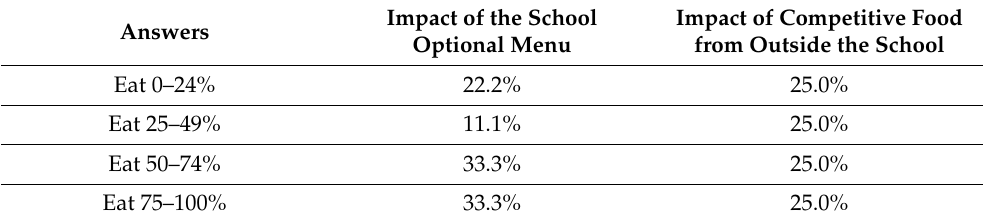
Table 4. Survey answers about the sources of competitive food.